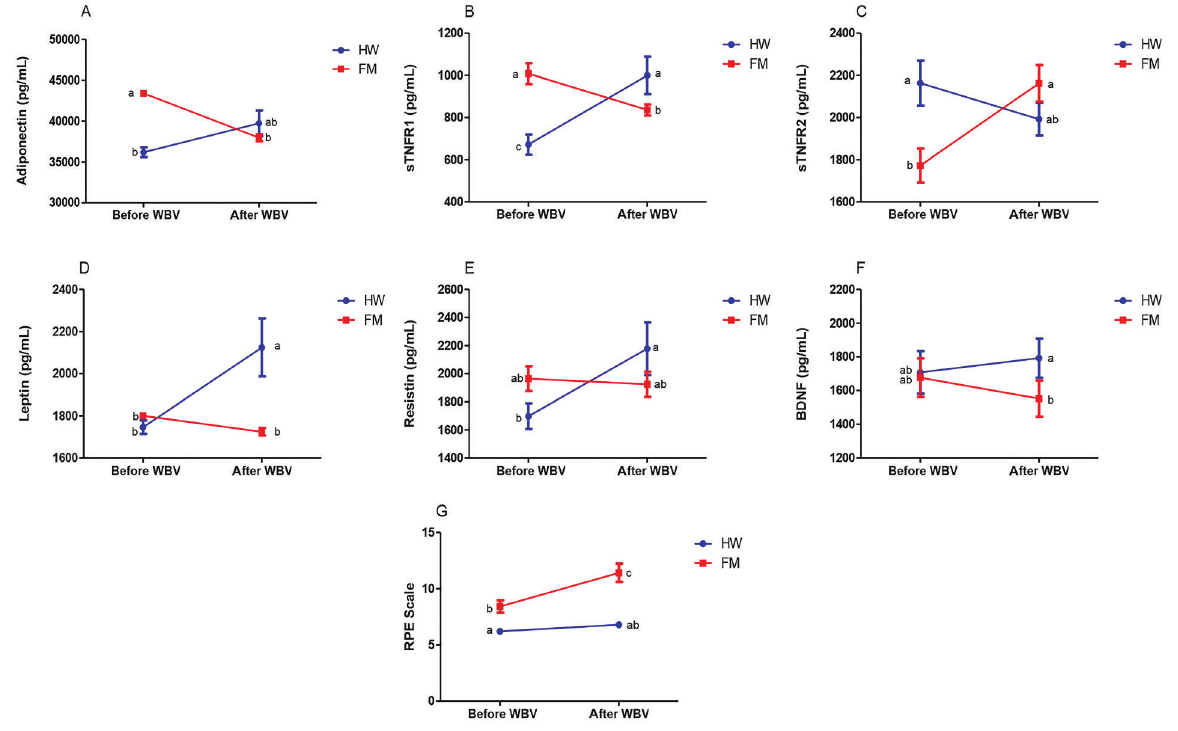
Figure 2. Interaction between biomarkers ( A – F ) before and after whole body vibration (WBV). Blue represents the healthy women group (HW, n=19) and red the fi bromyalgia women group (FM, n=19). Adiponectin ( A ), plasma soluble tumor necrosis factor-receptors 1 (sTNFR1) ( B ) and 2 (sTNFR2) ( C ), leptin ( D ), resistin ( E ), brain-derived neurotrophic factor (BDNF) ( F ), and Borg Scale of Perceived Exertion (RPE, G ) in healthy women and in fi bromyalgia women (FM; n=19). Data are reported as means ± SE. P o 0.05, different small letters indicate signi fi cant differences (Tukey ’ s